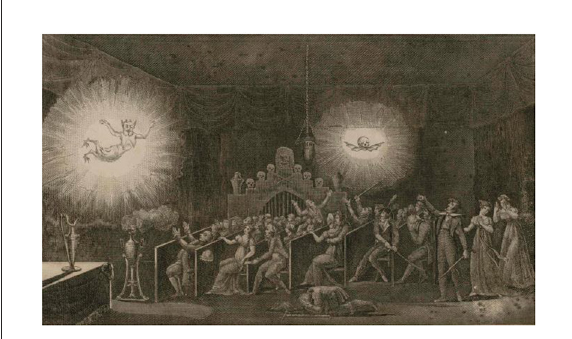
FIGURE2 Phantasmagoria display from the opening pages of Robertson